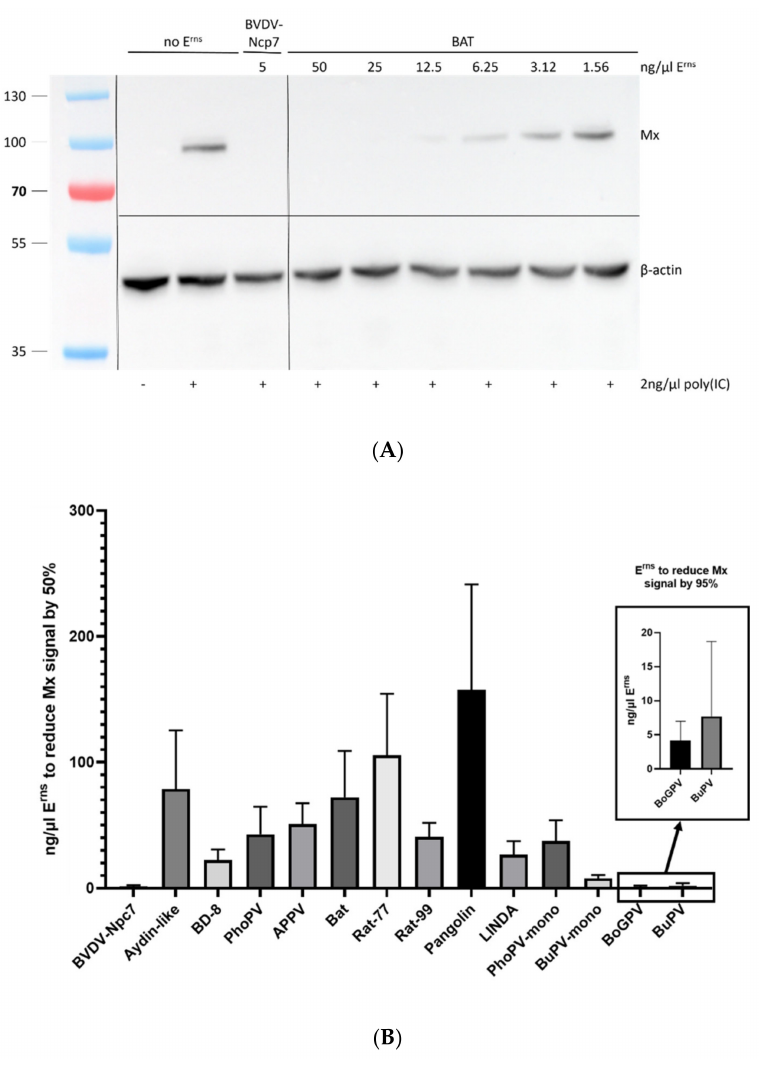
Figure 5. Inhibition of interferon expression was analyzed using the expression of Mx proteins as a proxy. ( A ): Example of a Western blot used to quantify the expression of Mx and the housekeeping protein β -actin in cells incubated with Bat-E rns and subsequently stimulated with poly(IC). The size (kDa) of the pre-stained protein ladder is indicated on the left. The uncropped gel is available in Supplementary Material Figure S3. ( B ): The amount of each E rns protein required to reduce the Mx signal by 50% is reported for the proteins that yielded a signal reduction sufficiently strong to be analyzed (n = 3 ± SD). As BoGPV- and BuPV-E rns were considerably stronger than the other proteins, their results are reported in the inset with a different scale on the y-axis and displaying the amount of these E rns proteins to reduce the Mx signal by 95%. Proteins that did not display any detectable activity (i.e., E rns of Gir-PG2, Gir-H138 and pronghorn antelope) are not shown. The activities of the various E rns proteins in relation to the one of BVDV-Ncp7 is shown in Table